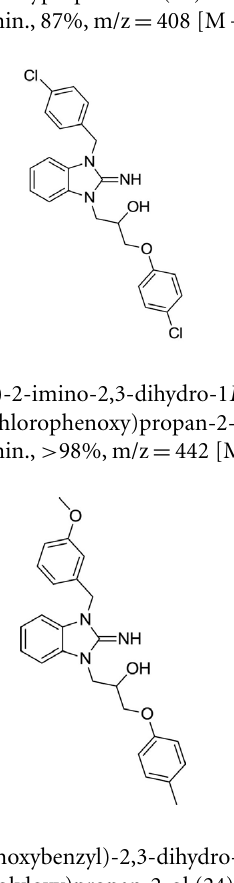
Figure 1B , VU573 inhibited GIRK-dependent Tl + flux in a dose- dependent manner with a 50% inhibition concentration (IC 50 ) of approximately 1.9 μ M ( Figure 1C